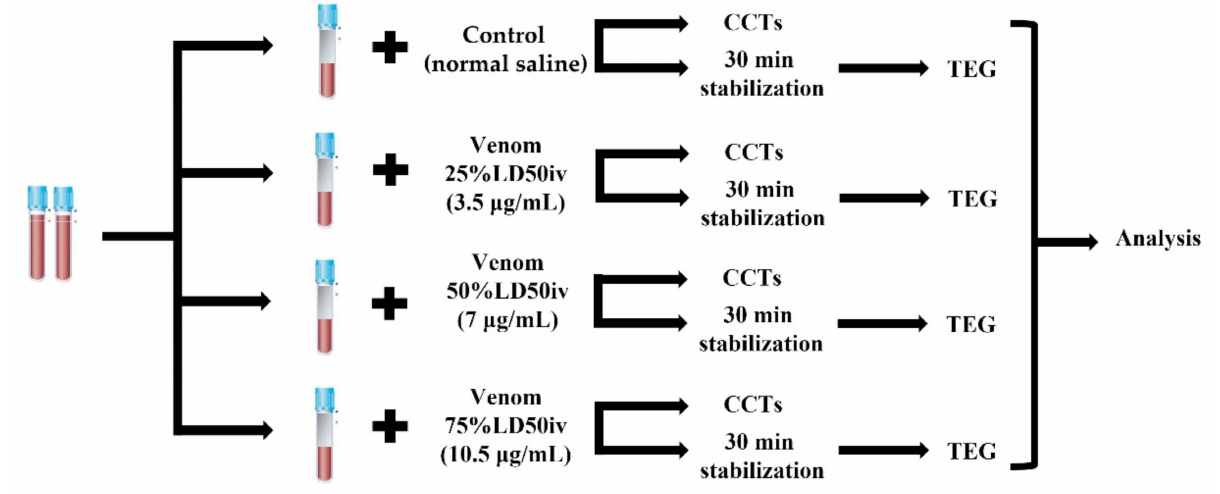
Figure 1. Timeline of the experimental design. The venoms of different concentrations were added to the blood samples in citrated tubes, whereas an equal amount of normal saline was added to the control blood sample. Each sample was assessed using CCTs and TEG, followed by statistical analyses. CCT, classical coagulation test; TEG,